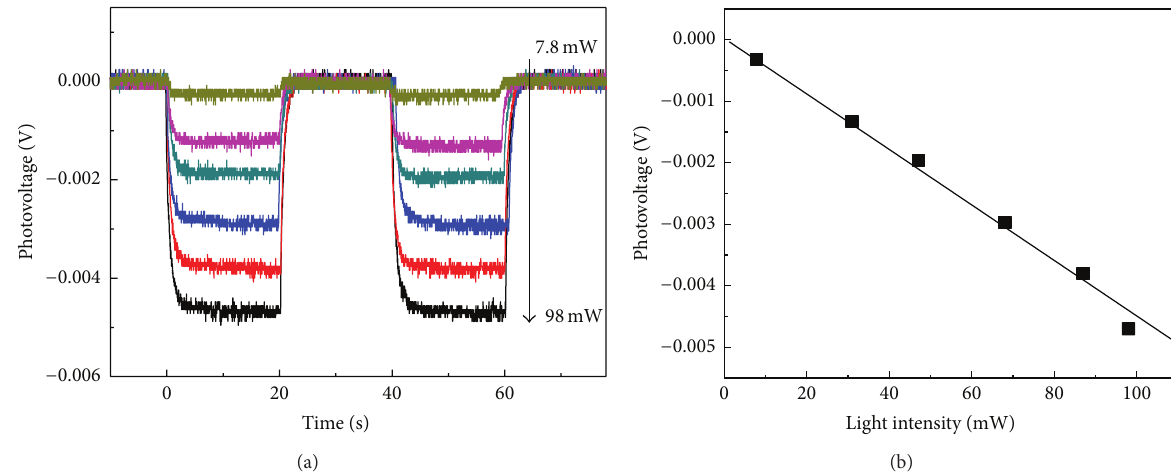
Figure 3: (a) The typical waveforms with different on-sample laser power from 7.8 to 98 mW at 𝑥 = −1.4 mm. (b) The LPV dependence on the on-sample laser power.